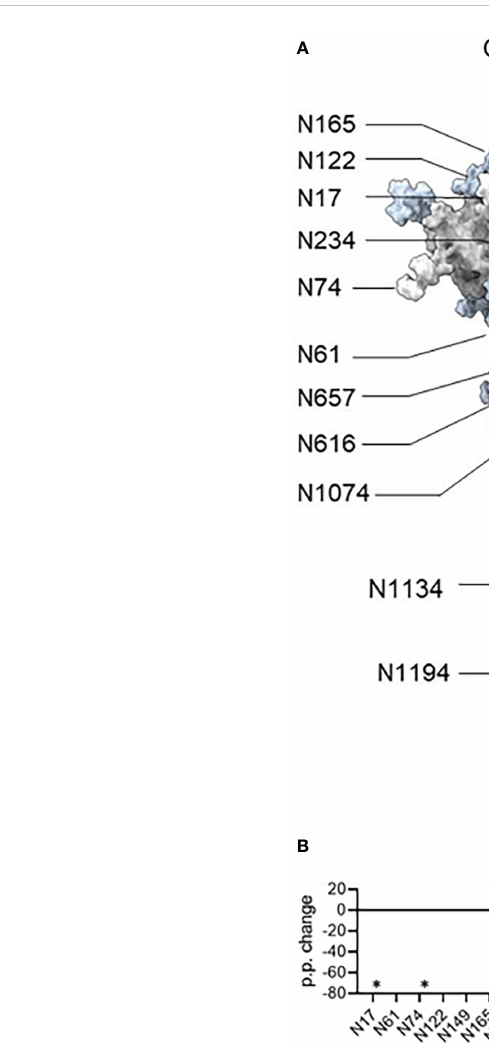
FIGURE 3 The change in site-speci fi c N-glycan occupancy of plant-produced and mammalian cell-derived spike. (A) Model of the SARS-CoV-2 S glycoprotein in the native-like prefusion conformation generated by Zuzic et al., (2022). Individual N-glycan sites are colored according to the percentage point change in glycan occupancy of plant-derived protein relative to the comparator HEK293F-produced protein and therefore positive and negative values represent a relative increase or decrease in the glycan occupancy each sequon. (B) Bar graph depicting the percentage point changes depicted in panel A. A negative value indicates lower glycan occupancy in the plant-produced spike protein. Sites that could not be resolved are denoted with an